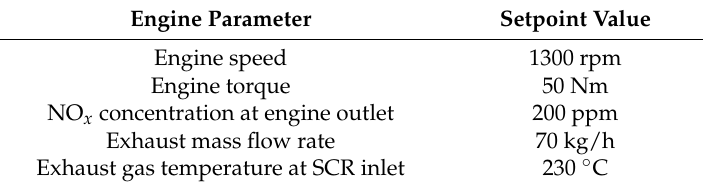
Table 1. Engine operation conditions during test run. SCR: selective catalytic reduction.